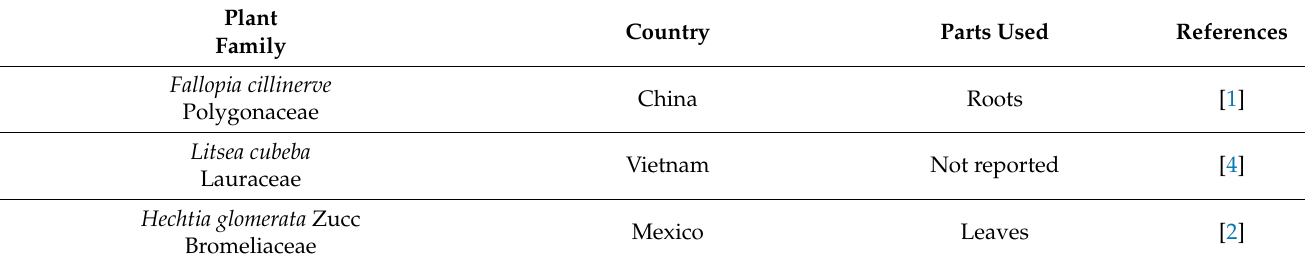
Table 1. Sources of